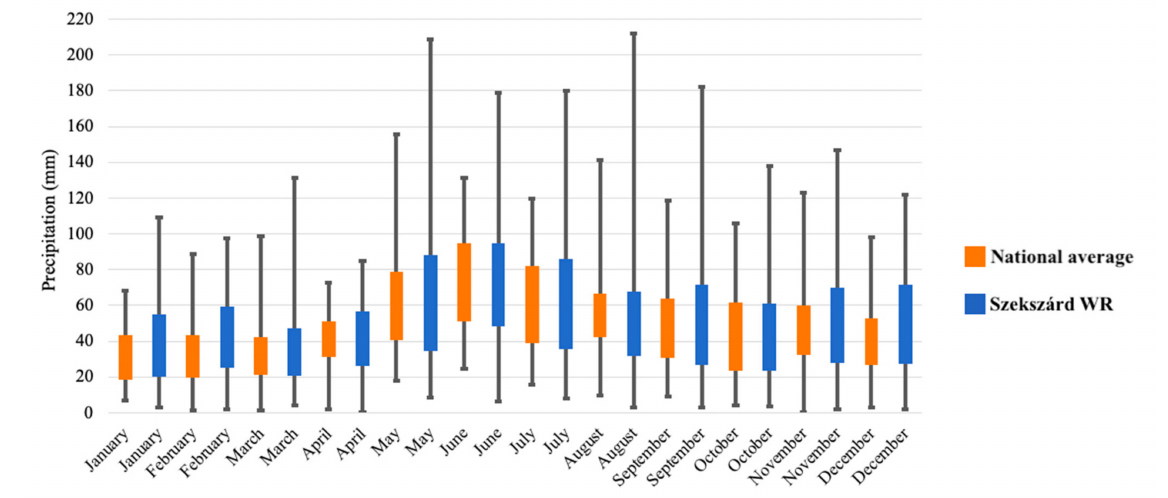
Figure 4. Monthly average precipitation and its variability between